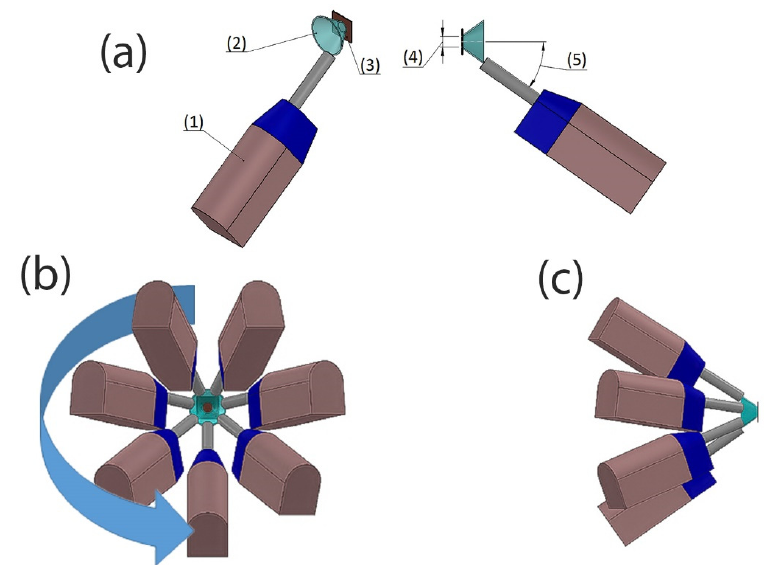
Figure 8. Metal Knitting strategy scheme. ( a ) (1) CS gun, (2) virtual frustum of cone path, (3) sub- strate, (4) radius, (5) angle. ( b , c ) simulation of different directions of view of CS gun describing the Metal Knitting movements.